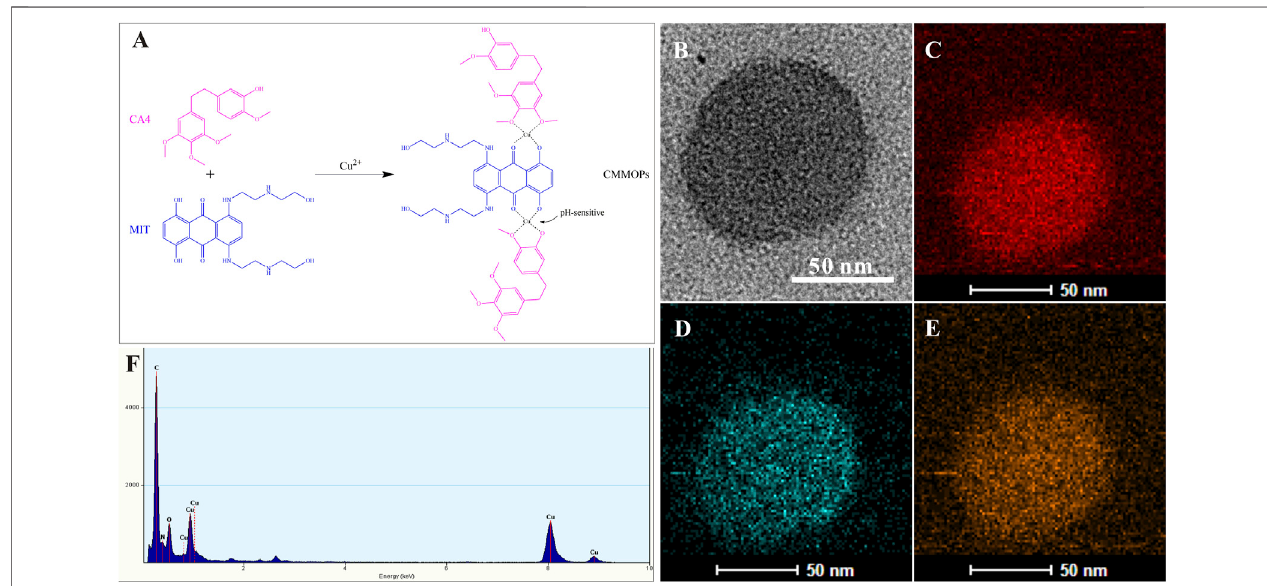
Frontiers in Bioengineering and Biotechnology |